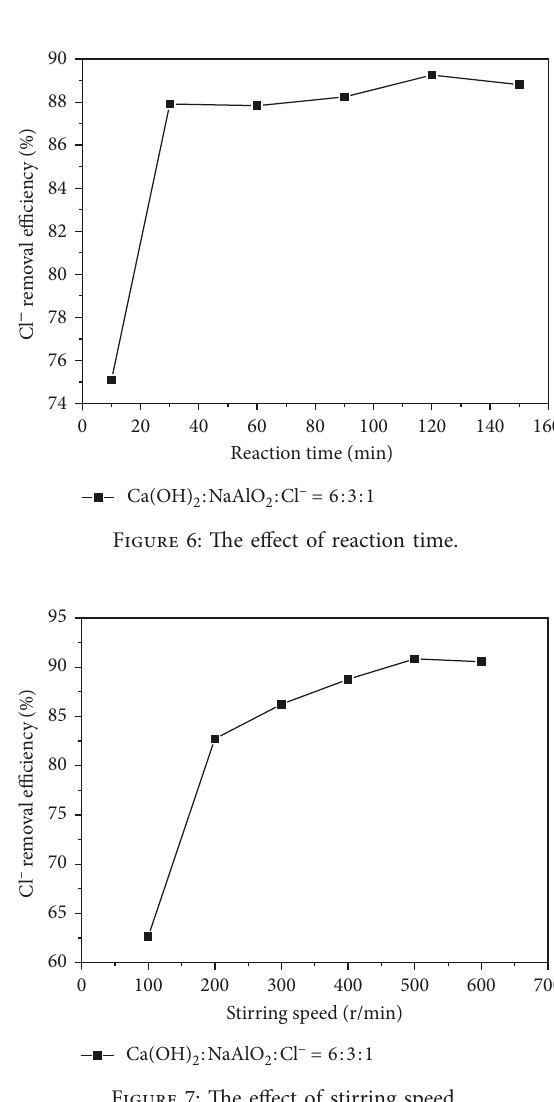
Figure 7: The effect of stirring speed.